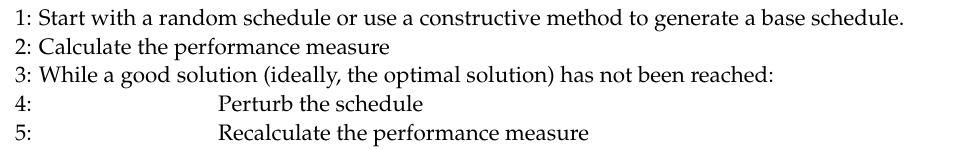
Algorithm 1 Solving a generic scheduling problem by an approximate